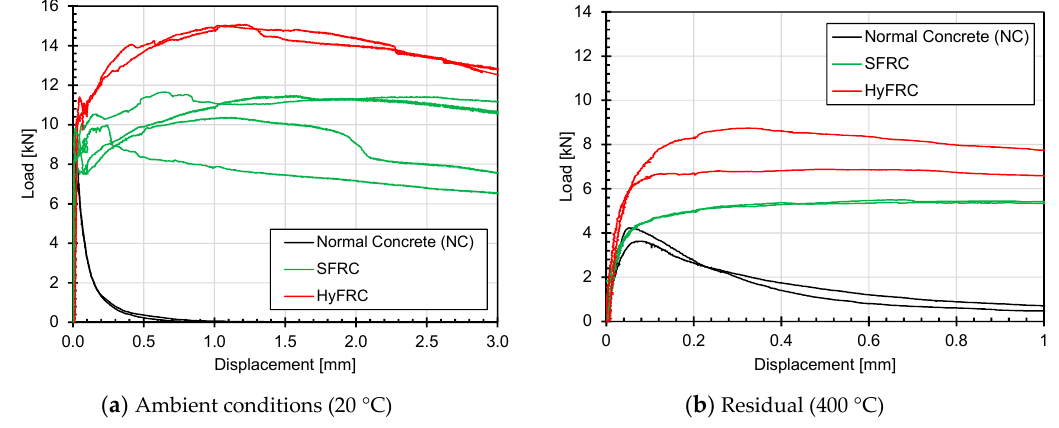
Figure 9. Load-displacement curves obtained from the flexural tests on notched beams.